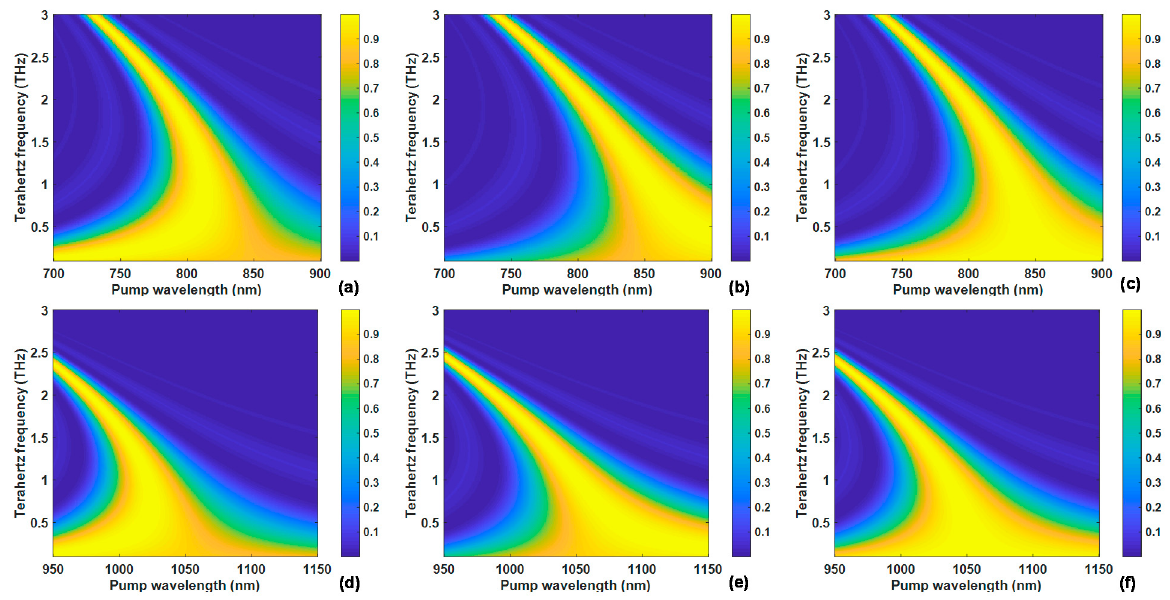
Figure 6. Coherence lengths of different OR interactions along the y ’ axis in the y’oz’ principal plane of ZnTe and CdTe with and without an applied voltage of 6 kV: ( a ) ZnTe crystal pumped at 800 nm and ( b ) CdTe crystal pumped at 1010 nm.